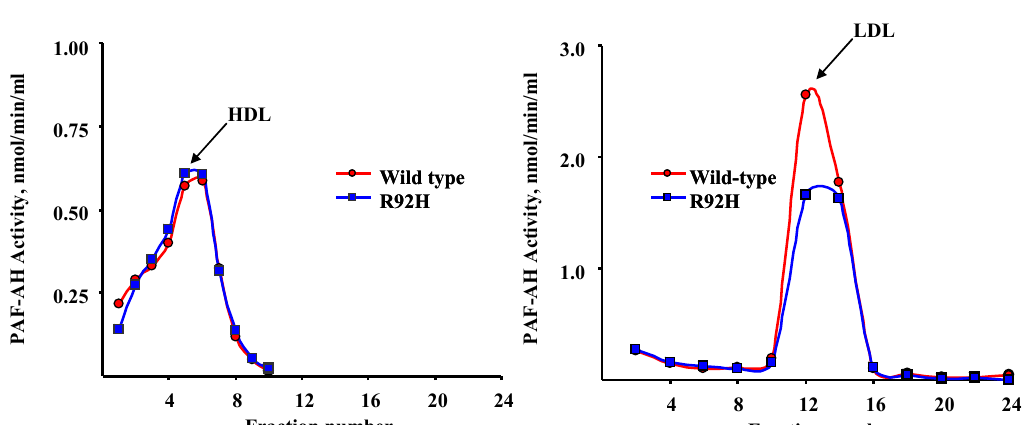
The top panel depicts amino acid sequences around R92 across several species. The bottom panels show that recombinant human R92H binds to HDL (left panel) and LDL (right panel) in manners similar to those of wild-type